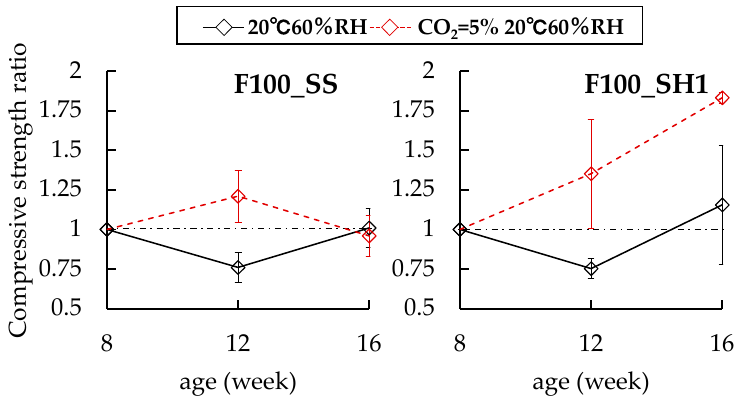
Figure 4. Changes in compressive strength ratios of B50F50 specimens at 8 weeks.